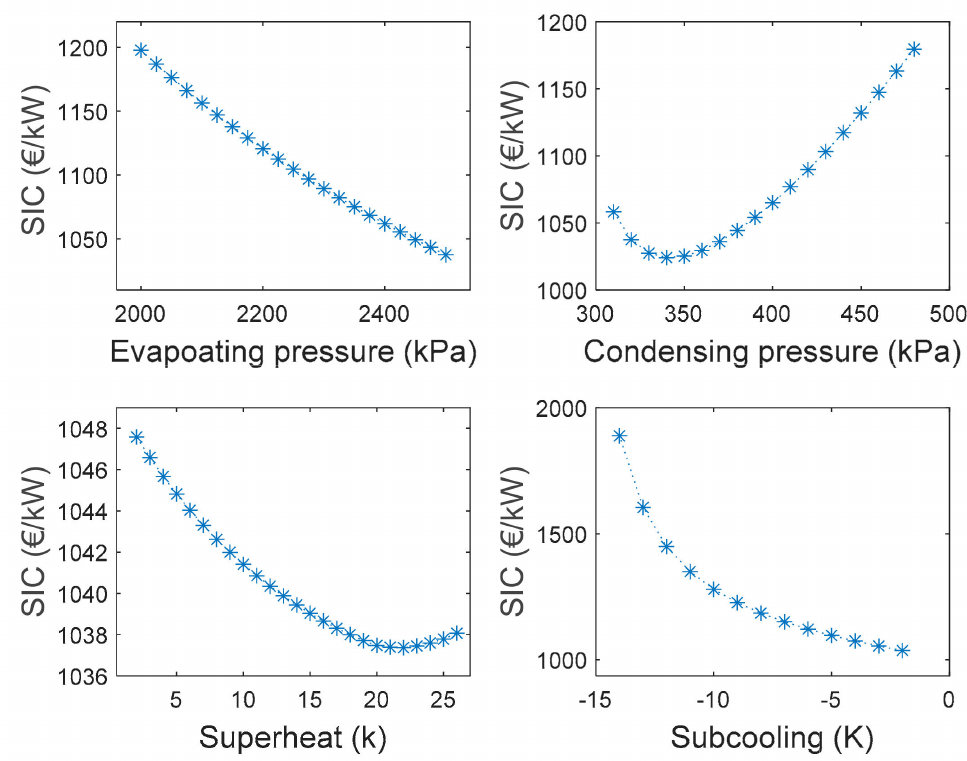
Figure 2. Impact of the operating parameters on the optimization objective